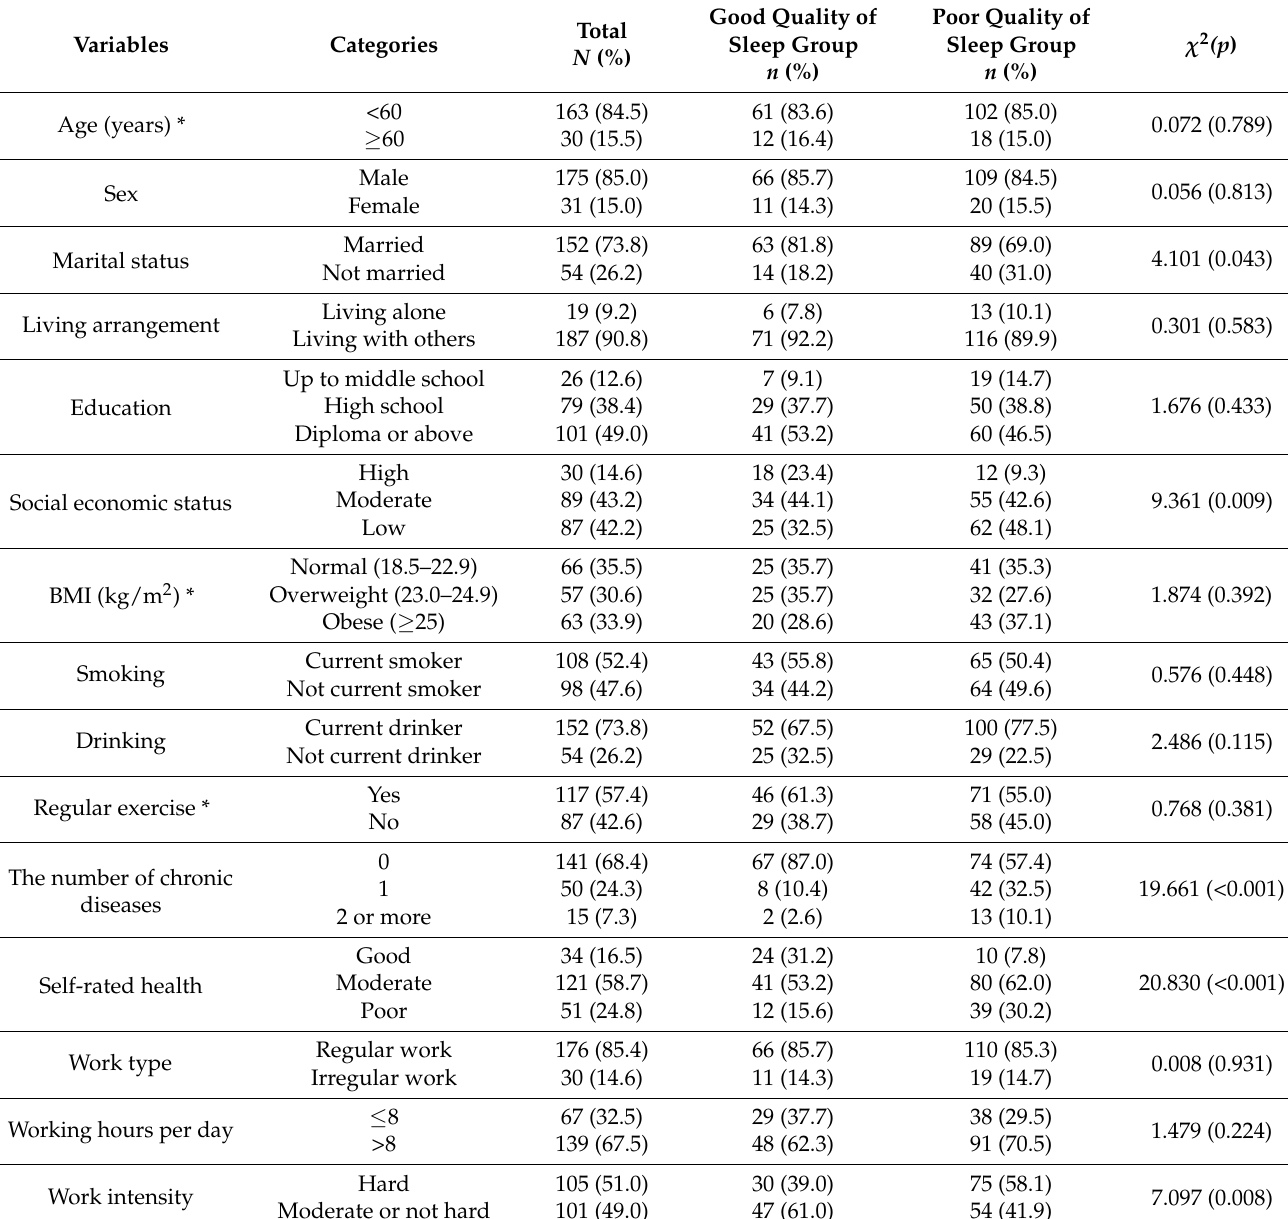
Table 1. Differences of general characteristics between the two sleep quality groups ( N =